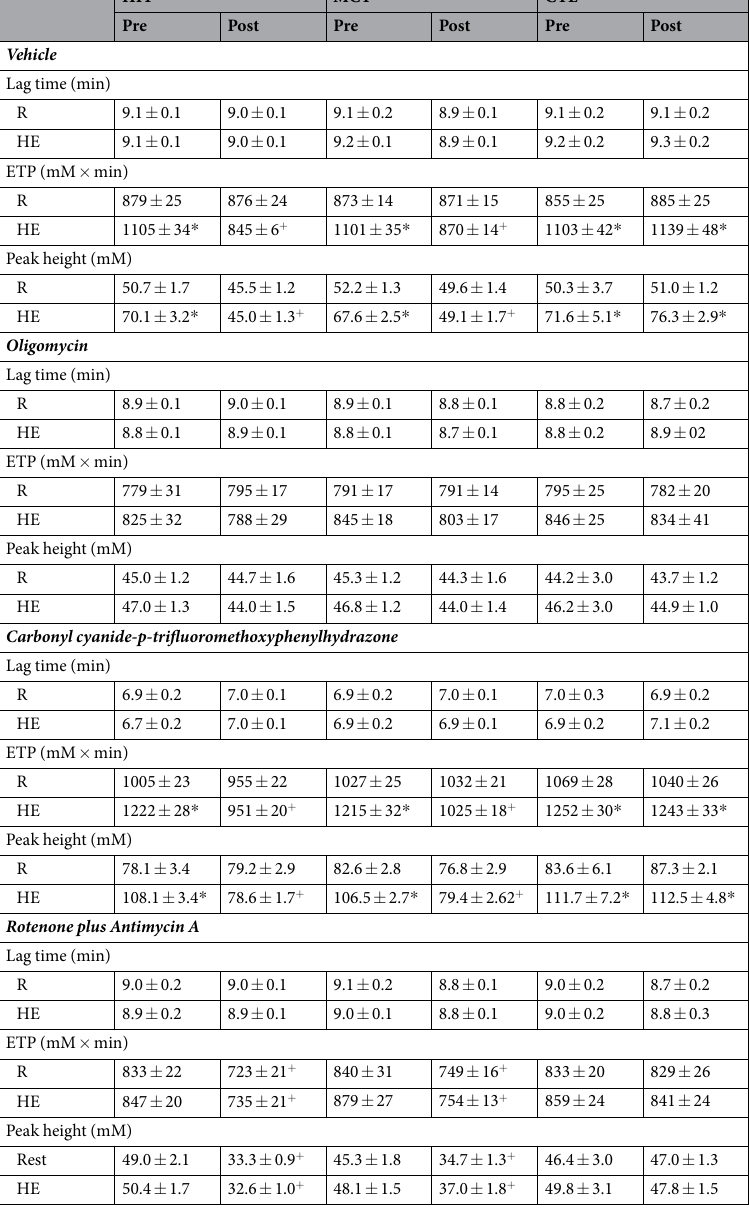
Table 4. The effects of interval and continuous exercise regimens on dynamic thrombin generation in platelet- rich plasma. Values were mean ± SEM. HIT, high-intensity interval training group; MCT, moderate-intensity continuous training group; CTL, control group; Pre, pre-intervention; Post, post-intervention; R, resting; HE, hypoxic exercise test; ETP, endogenous thrombin potential. * P < 0.05, R vs. HE; + P < 0.05, P re vs.